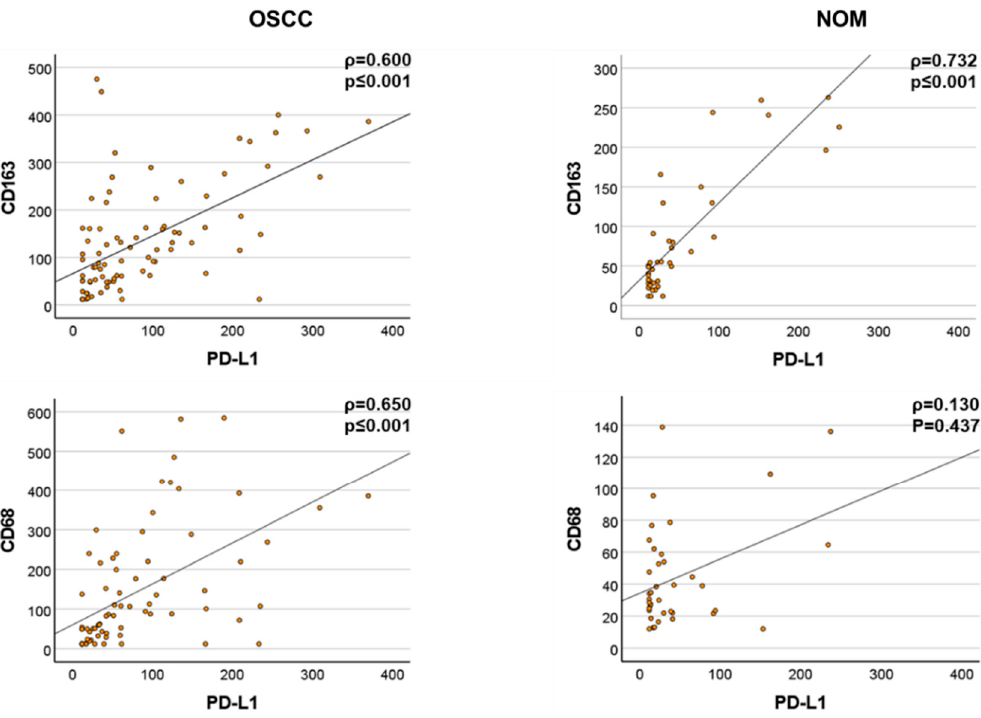
Figure 4. Positive significant correlations between PD-L1 and CD163 expression in the OSCC and NOM groups. Expression levels of CD68 and PD-L1 were strongly correlated in the OSCC ( n = 98) but not in the NOM group ( n = 41).